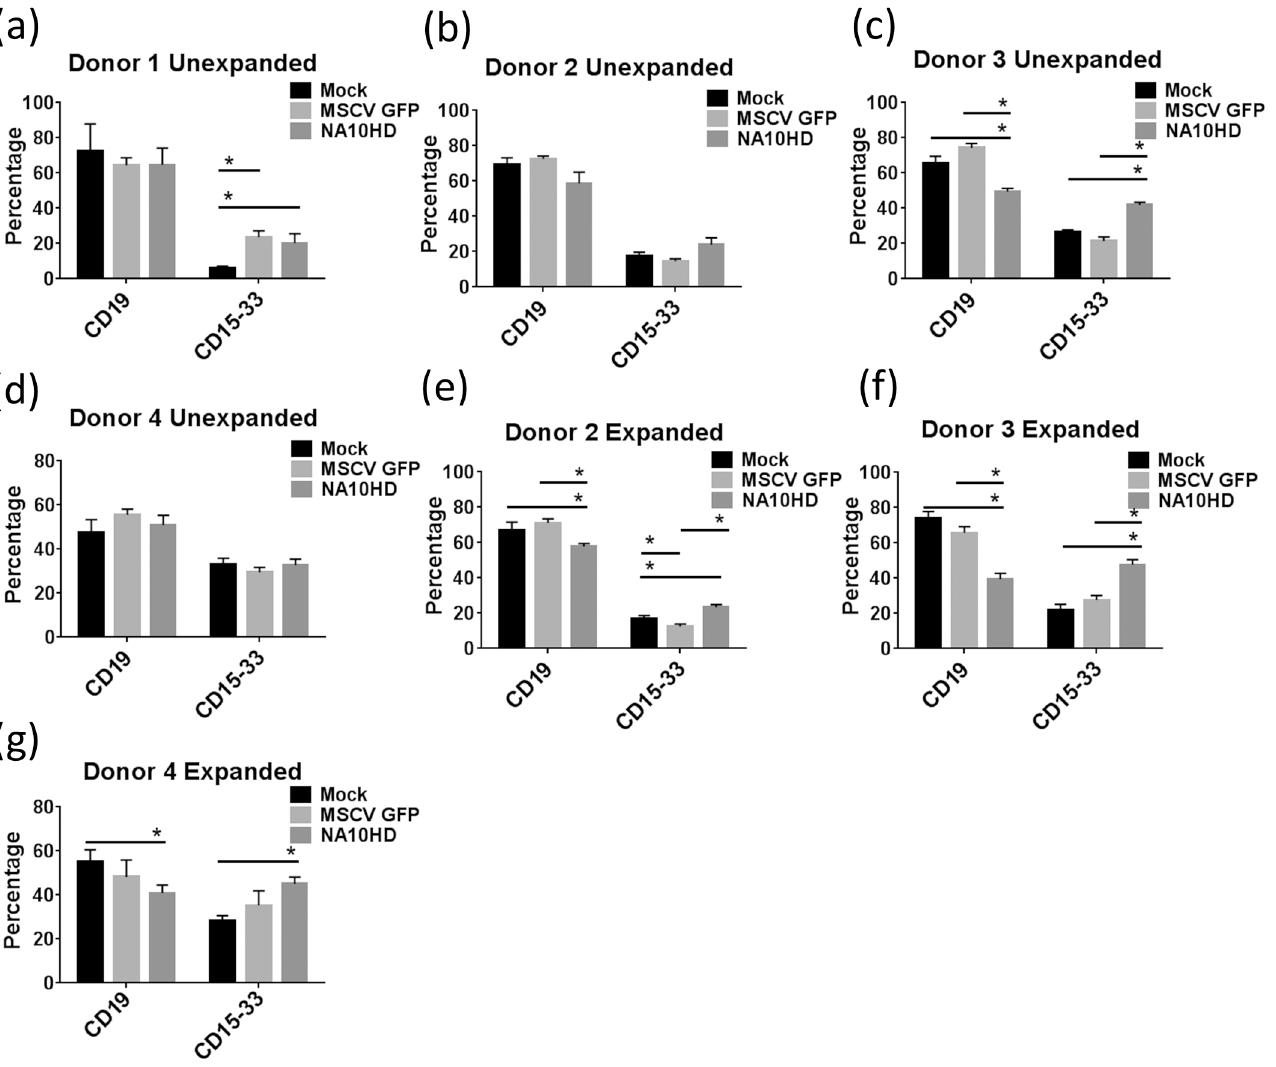
Fig 7. Distribution of CD19+ and CD15/33+ cells amongst CD45+ engrafted cells. CD45+ cells recovered from bone marrow harvested from NSG mice 12 – 15 week post transplantation with lentiviral transduced CD34+ cells that remained in culture for 24 hours after transduction (a)-(d) or for one week after transduction (Expanded) (e)-(g). Statistical comparisons performed using Mann-Whitney U testing with a p-value of 0.05 being considered significant ( *